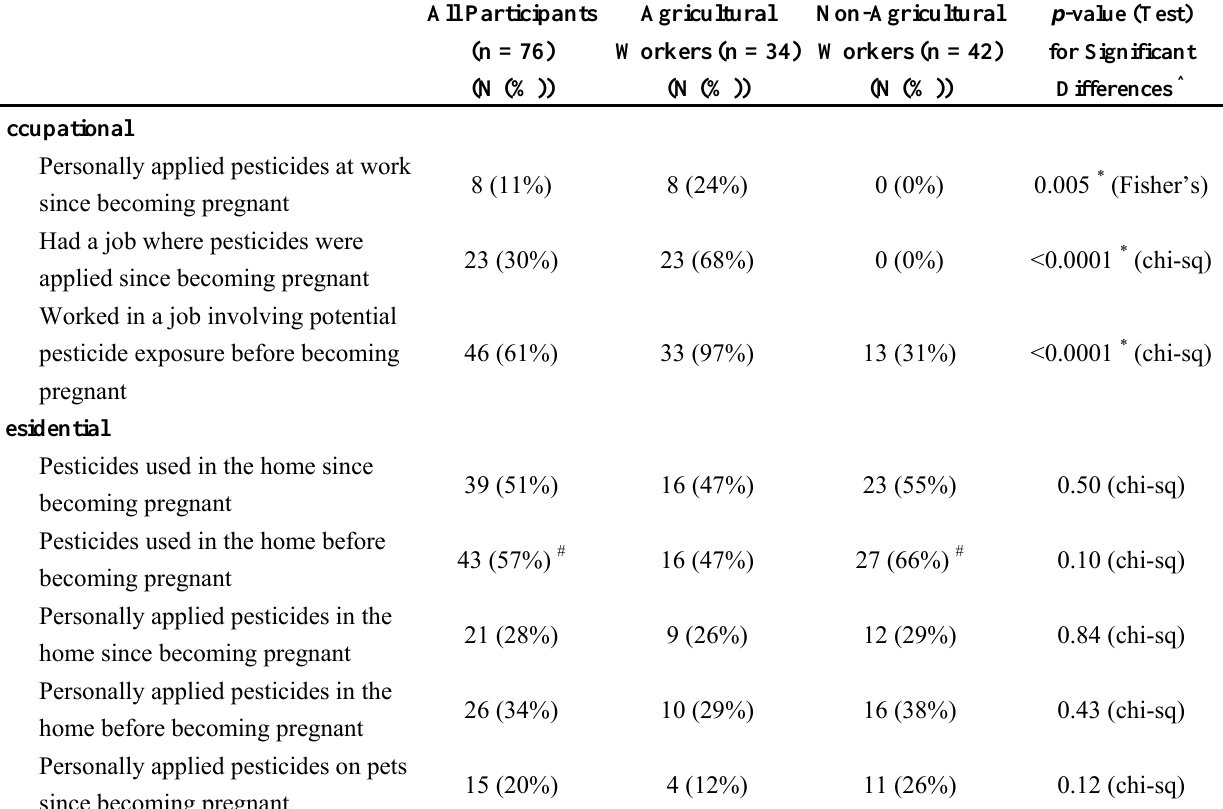
Table 2. Pesticide use characteristics of all participants and by